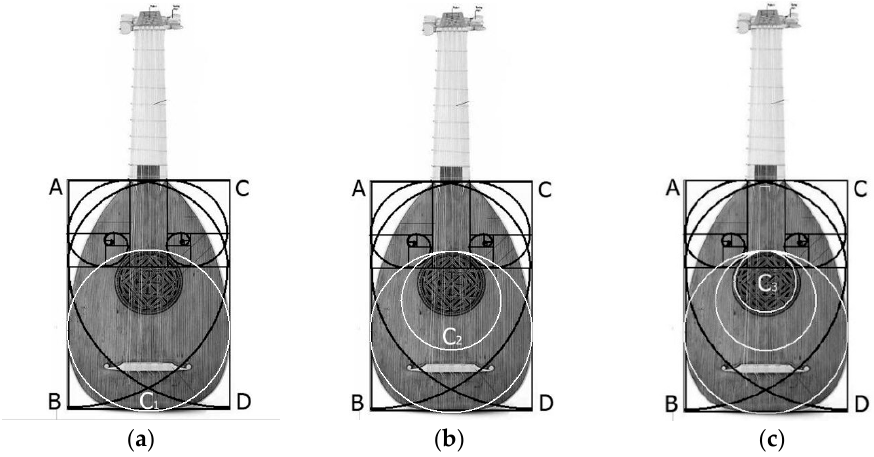
Figure 4. ( a ) Step four: Circle C 1 , ( b ) step five: the first golden circle, ( c ) step six: the second golden circle.